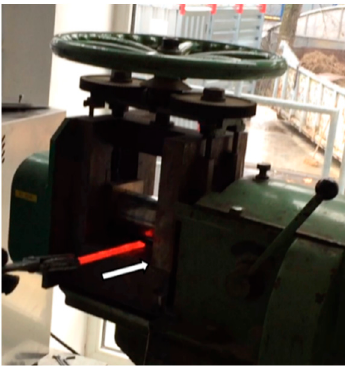
Figure 1. Rolling the heated container on the laboratory rolling mill.